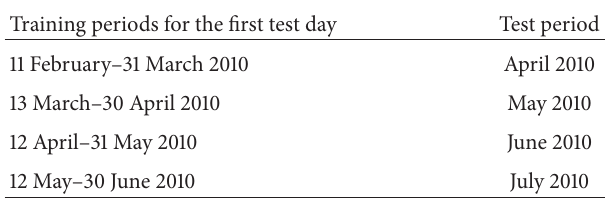
Table 1: Training and test data